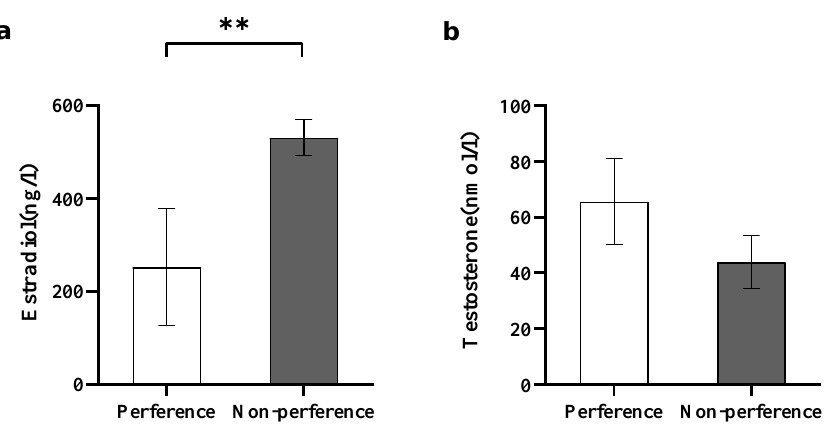
Figure 4. Comparison of sex hormone levels. ( a ) Estradiol levels in females in Experiment 1; ( b ) Testosterone levels in males in Experiment 2. A significant difference is denoted by an